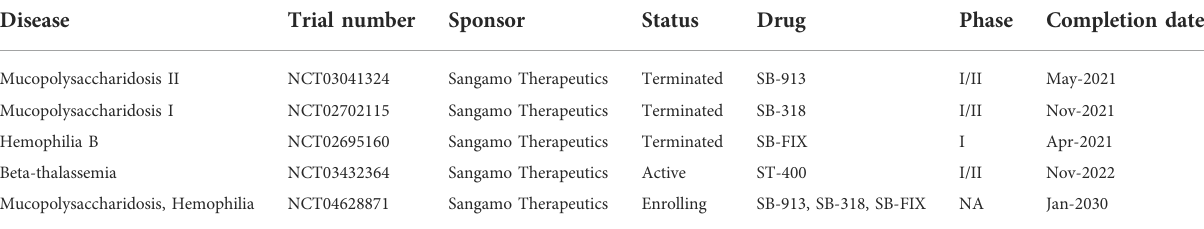
TABLE 2 Summary of ZFNs ongoing clinical